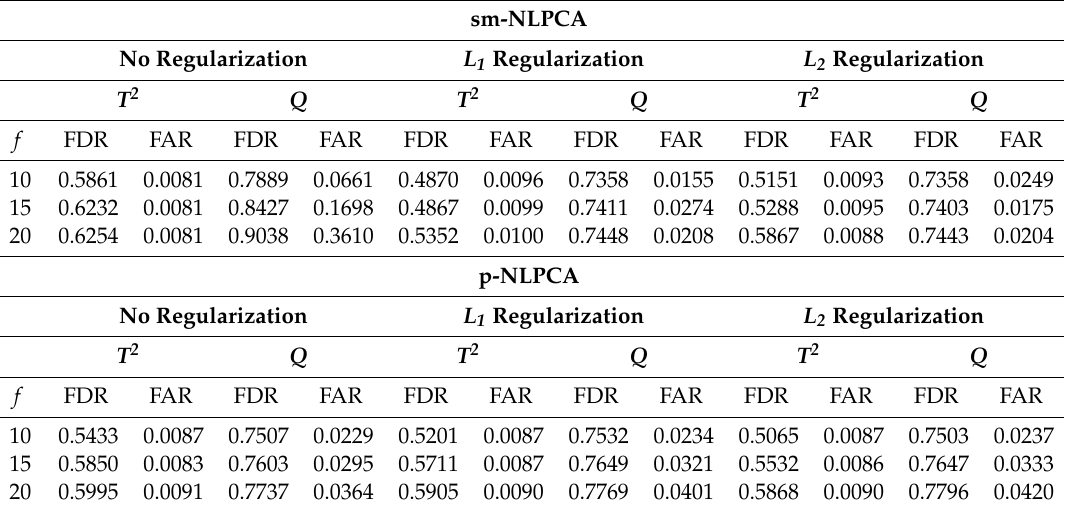
Table 7. Process monitoring results with neural network regularization (Network Type 2).